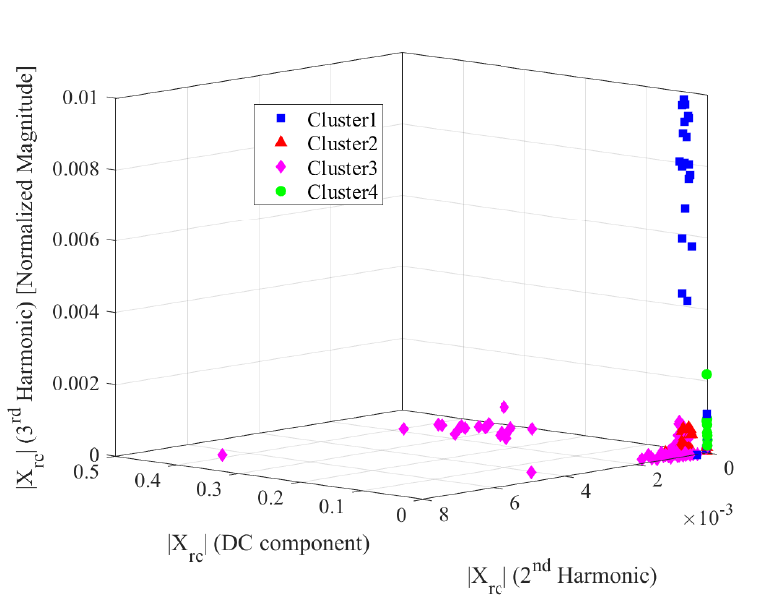
Figure 7. Scatter plot of rotor current harmonics as feature data.